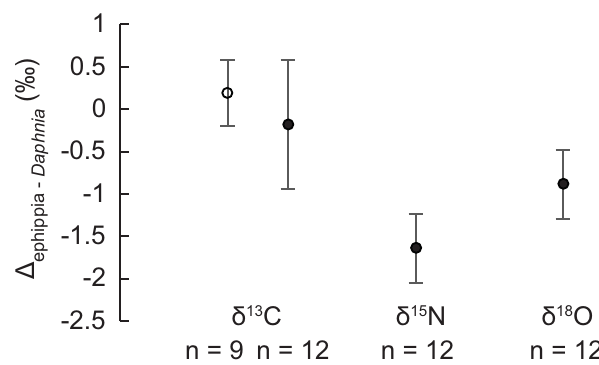
Figure 4. The difference in δ 13 C, δ 15 N and δ 18 O values between ephippia and Daphnia for all four treatments (closed circles). The open circle gives the offset for the three treatments at 12 ◦ C exclud- ing Treatment 4 (20 ◦ C), which yielded unexpected results for δ 13 C (see text). Error bars indicate standard